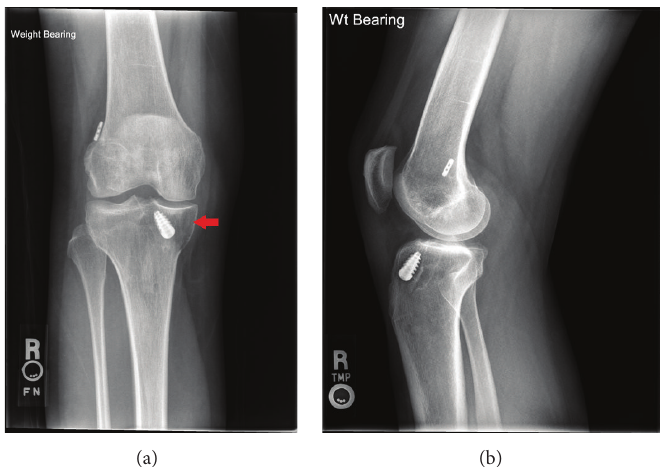
Figure 4: AP (a) and lateral (b) weight bearing radiographs of right knee obtained at the time of knee reinjury, approximately 6 months after the ACL reconstruction surgery. Retrospectively, new lucent lesion adjacent to the tibial tunnel is present (arrow).